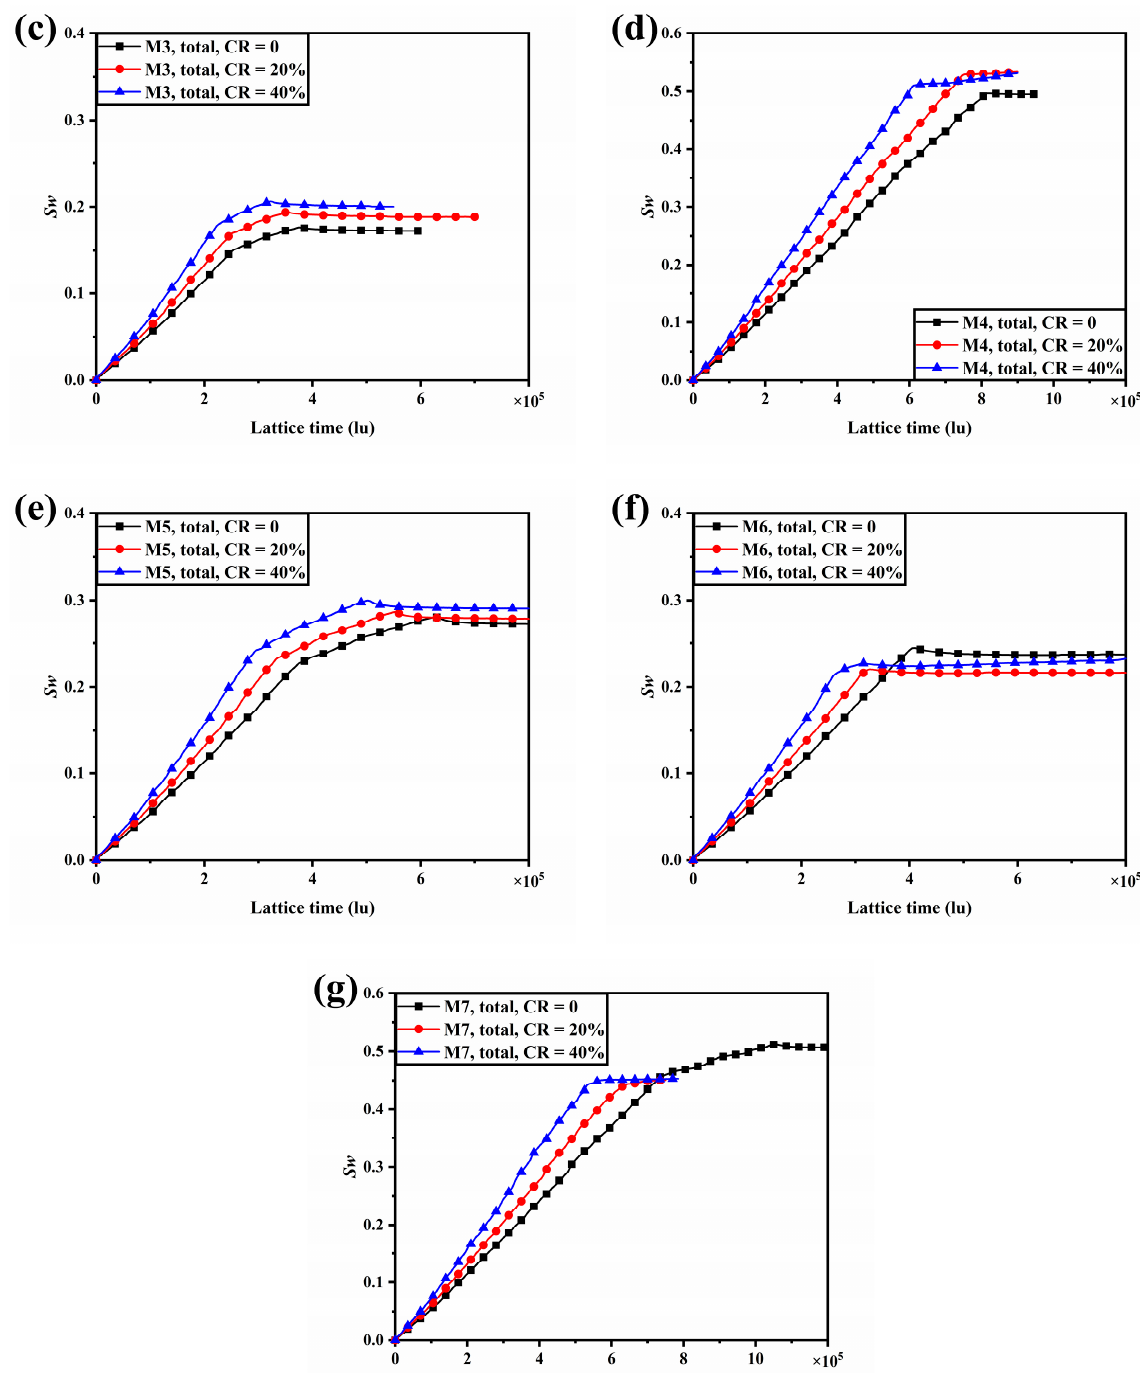
Figure 8. The evolution of water saturation within the seven different porosity gradients of GDL considered at CR = 0, 20%, and 40% with time, ( a ) M1; ( b ) M2; ( c ) M3; ( d ) M4; ( e ) M5; ( f ) M6; and ( g ) M7.